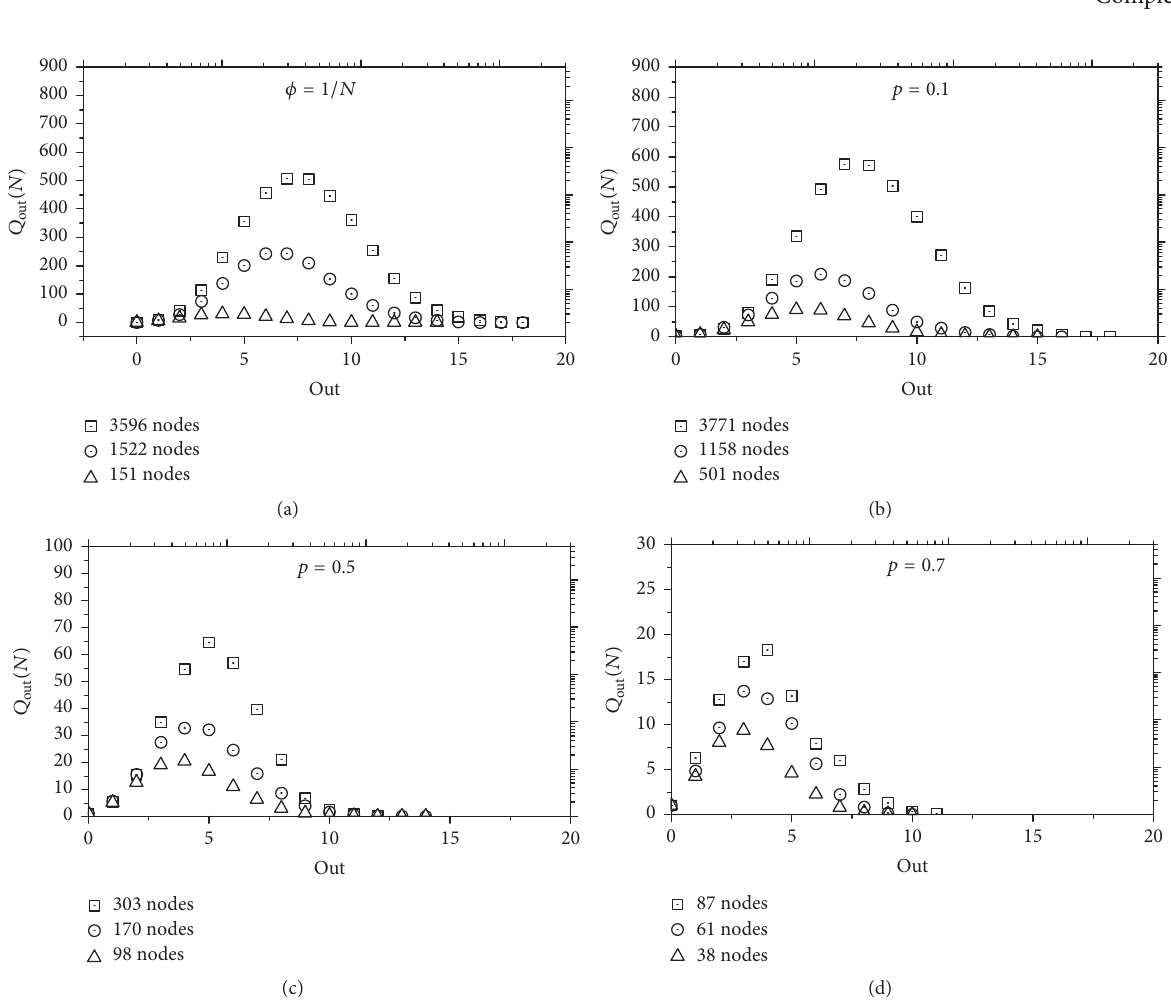
Figure 7: Out-degree distributions of islands with different sizes founded in the networks generated with the proposed model with 𝜙 = 1/𝑁 (a) and 𝑝 = 0.1, 0.5 , and 0.7